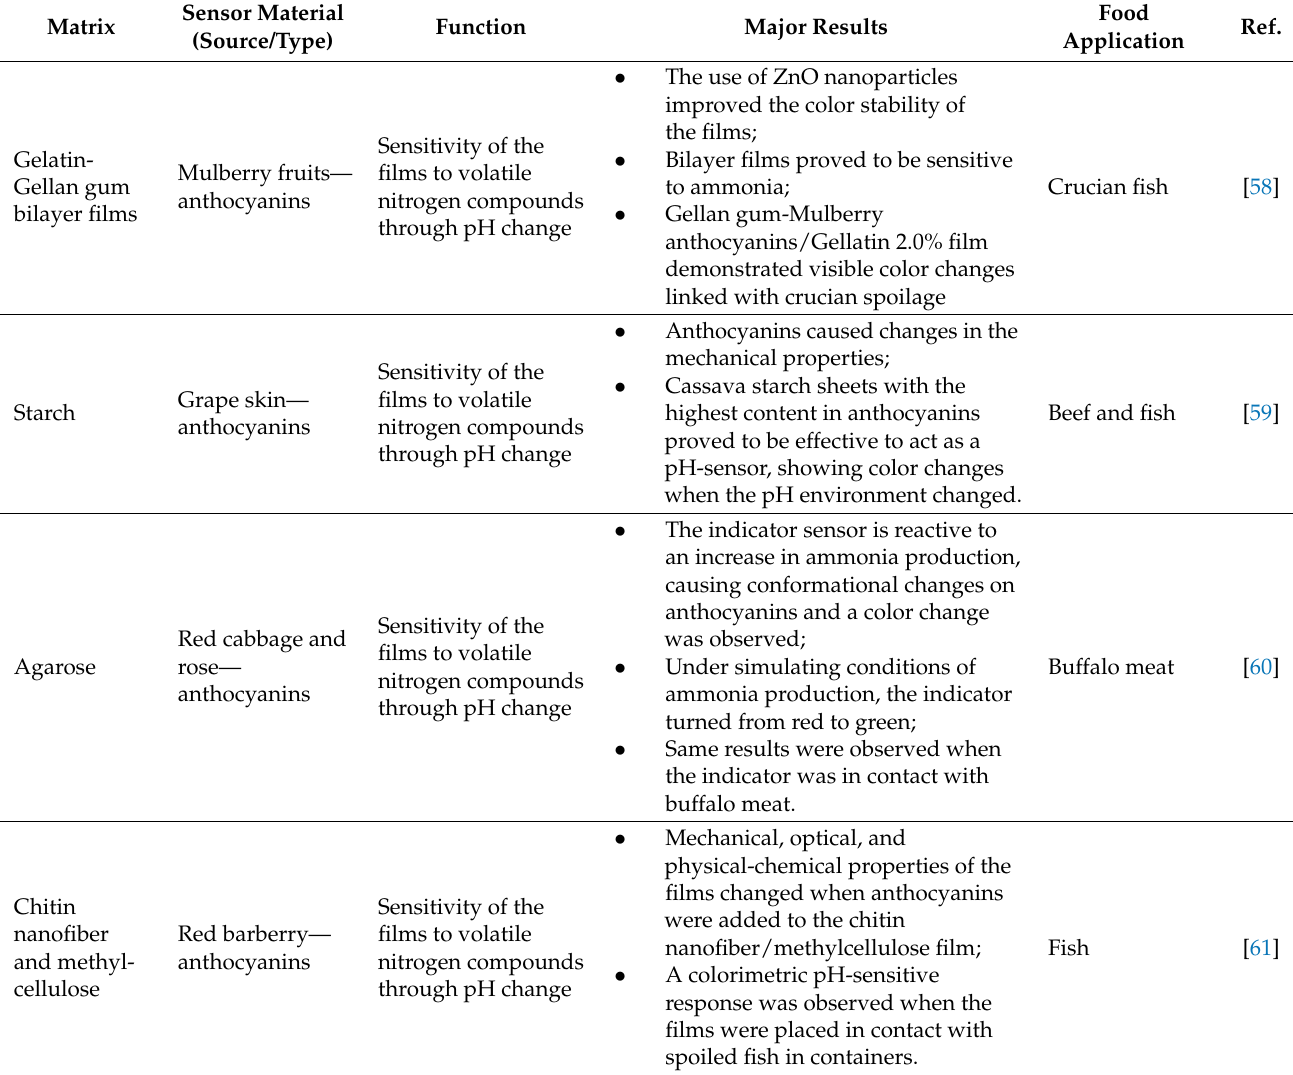
Table 1. Food application of bio-based pH